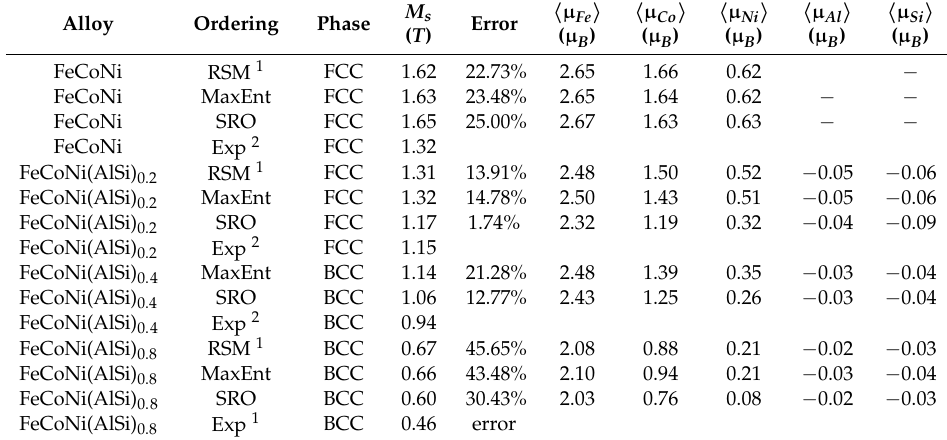
Table 5. The saturation magnetizations M s , the errors of calculated saturation magnetizations to experimental values and average magnetic moments (cid:104) µ i (cid:105) for FeCoNi(AlSi) x alloys with the MaxEnt structures and the finial structures with SRO, the calculated and experimental data from previous publications are also shown.